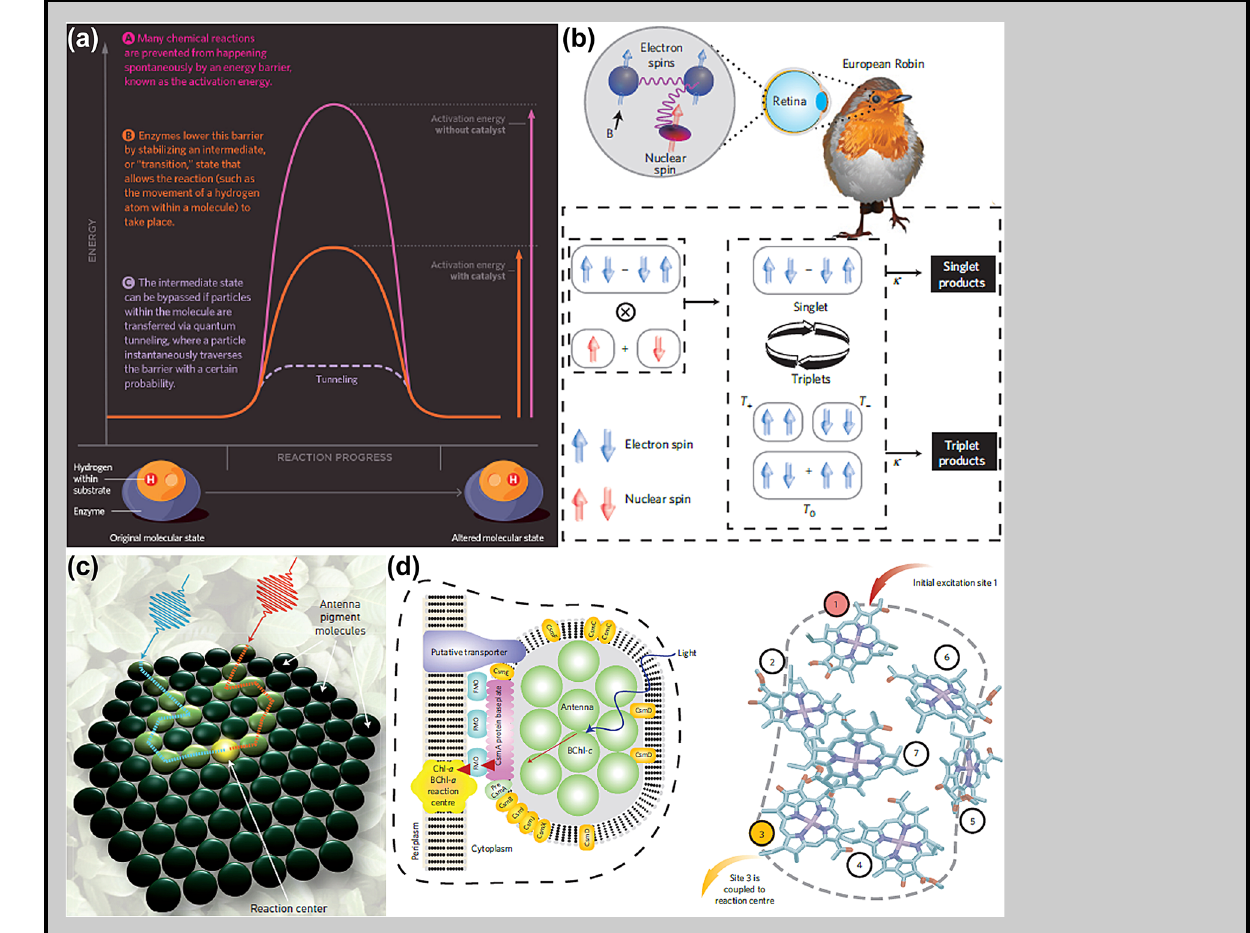
Figure B  : (a) Schematic of enzyme catalysis process with possible quantum tunnelling as an activation energy lowering mechanism. Adapted with permission from Lucy Reading-Ikkanda from the study by Offord [  ]. (b) The schematic of the avian quantum compass involving the possible radical-pair mechanism in avian magnetoreception in birds such as European robin. Reprinted by permission from SpringerNature:NaturePhysics[  ],copyright(  ).(c)Asemiclassicalschemeoftherouteofanexcitontowardsthereactioncentrewhere the exciton is stimulated by a photon from sunlight. The coherence observed in two-dimensional spectroscopy experiments points to the quantumpictureintheprimarystageof photosynthesis process involvingelectronicvibrational resonancesfacilitatingtheenergytransfer. Adapted with permission from Phil Saunders from the study by Wills [  ]. (d) FMO complex in the light-harvesting apparatus of green- sulphur bacteria shows signatures of quantum coherent energy transfer. Left: The photosynthetic apparatus depicting its antenna, energy- conductingbaseplateandFMOcomplexes,aswellasreactioncentre.Right:AnX-raydiffractiondiagramoftheBChl-aarrangementsofone of the FMO pigment-protein complexes. Reprinted by permission from Springer Nature: Nature Physics [  ], copyright ( 